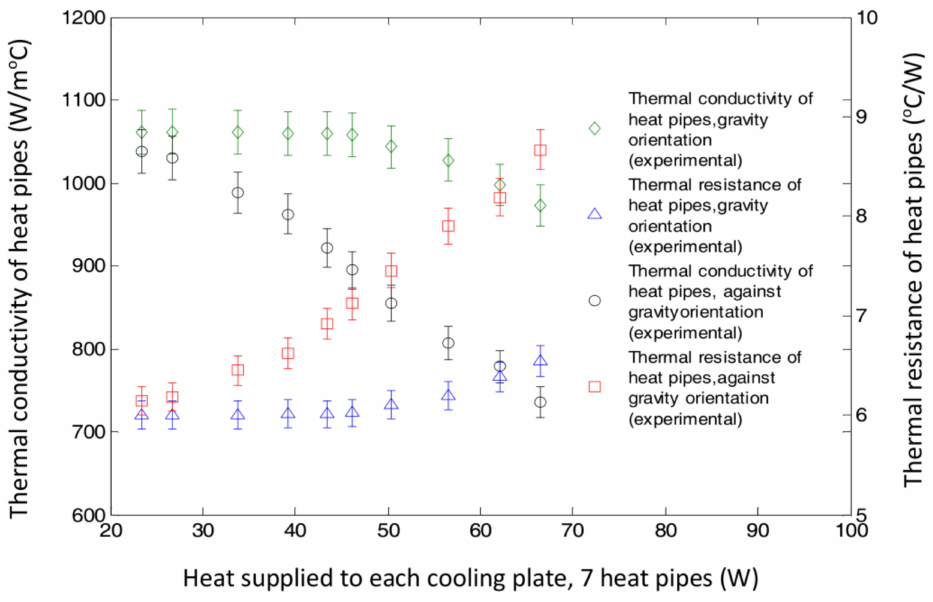
Figure 8. Effective thermal conductivity and thermal resistance of heat pipes (diameter of 6 mm, effective length of 190 mm pressed thickness of 2 mm and width of 8.50 mm at the evaporator section) as a function of heat supplied by a DC power supply for two different orientations (gravity and against gravity); maximum 1.5% error is associated with the data for thermal resistance and 2% error associated with the thermal conductivity